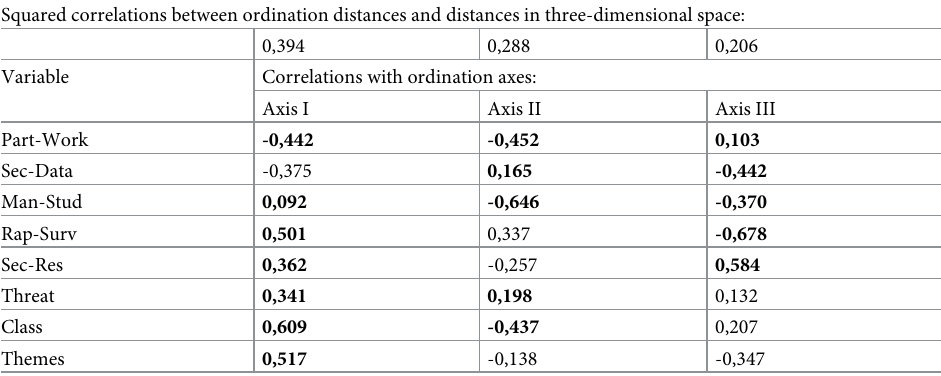
Table 4. Pearson’s correlations of each variable and axes I, II and III of the NMDS analysis. Squared correlations between ordination distances and distances in three-dimensional